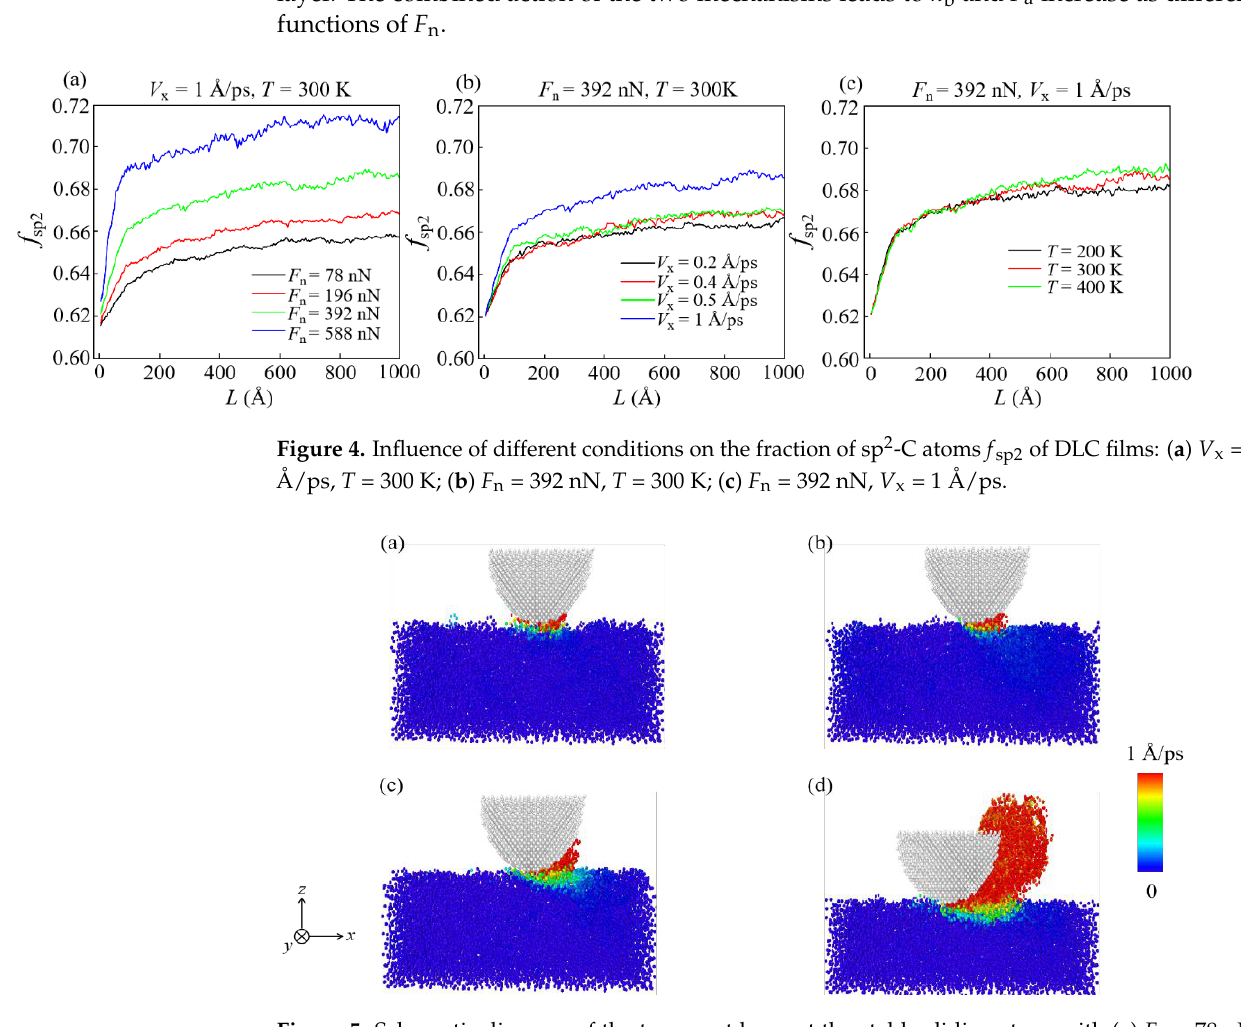
Figure 5. Schematic diagram of the transport layer at the stable sliding stage with ( a ) F n = 78 nN, ( b ) F n = 196 nN, ( c ) F n = 392 nN, and ( d ) F n = 588 nN.